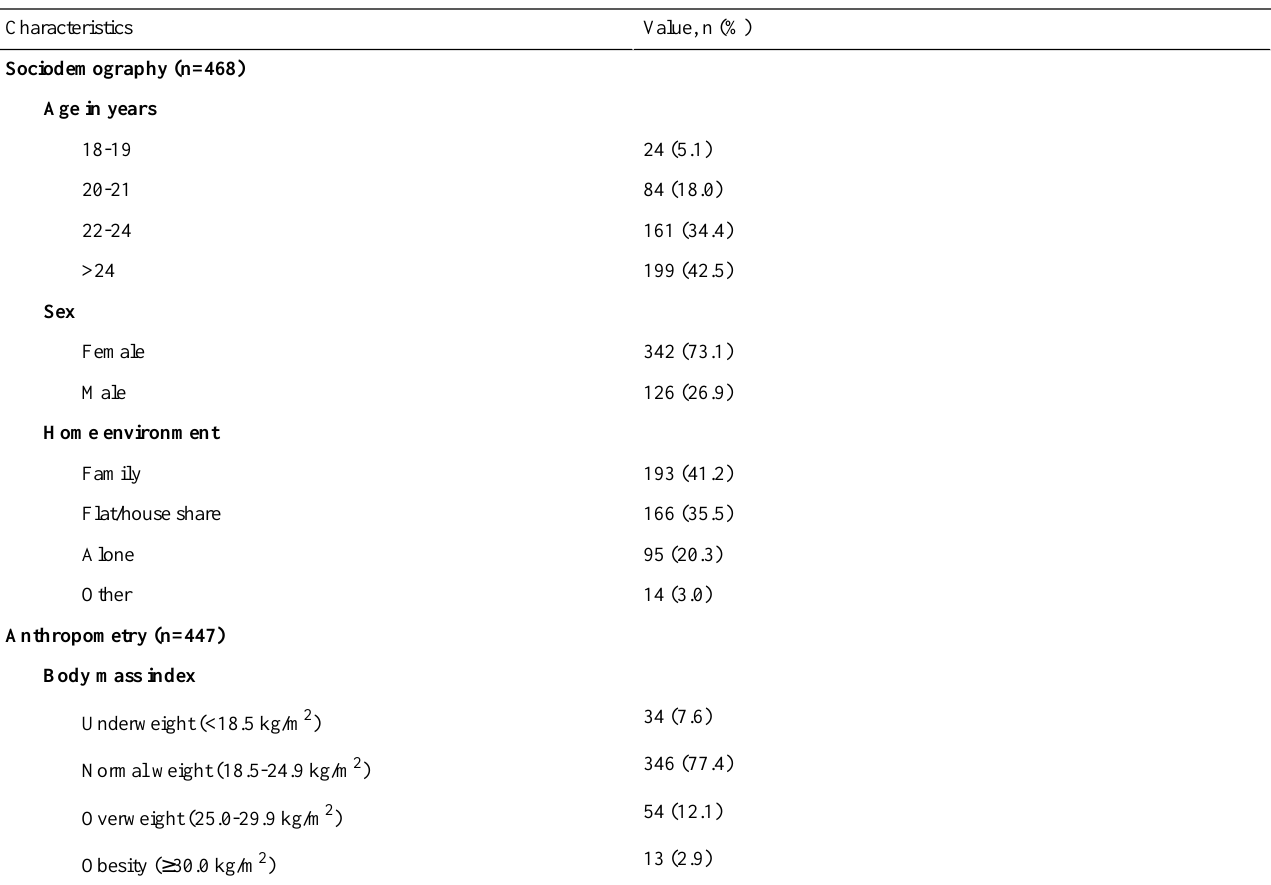
Table 1. Characteristics of survey